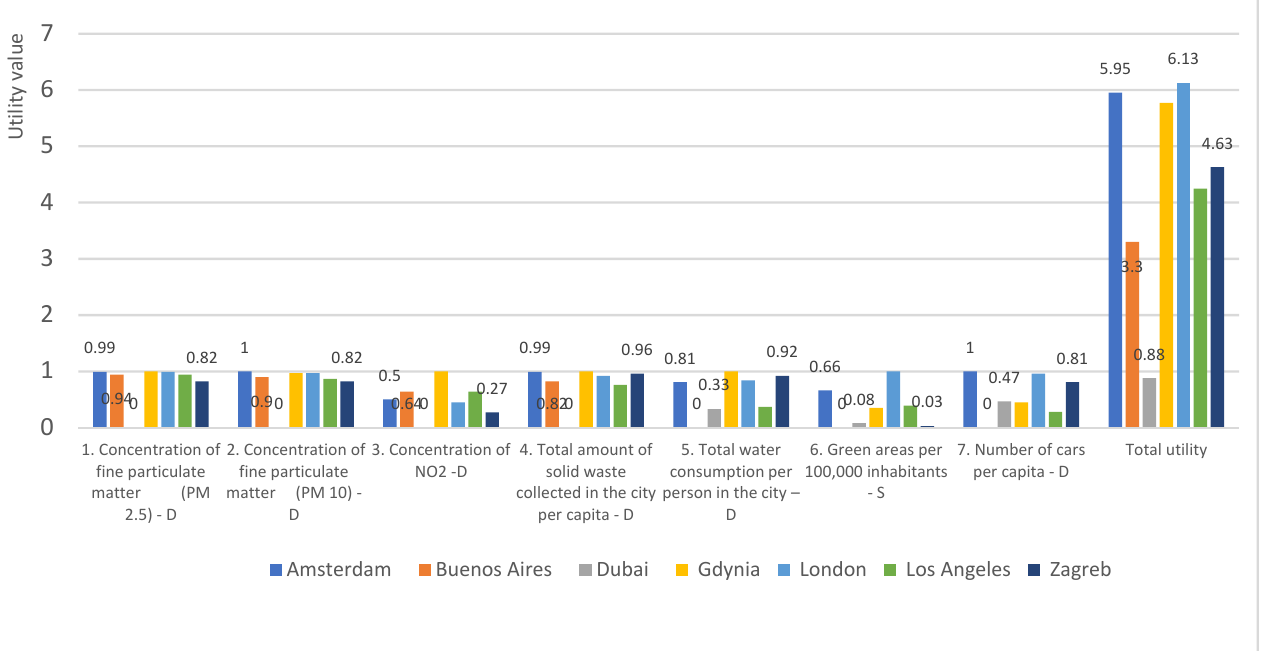
Figure 2. Partial and total utility for the economic dimension indicators. In terms of social order, the best place was taken by the city of Gdynia with a total utility value of 5.56. Four indicators reached a partial value within the range between 0.99 and 1, i.e., maximum and these are: number of firefighters per 100,000 inhabitants, under-